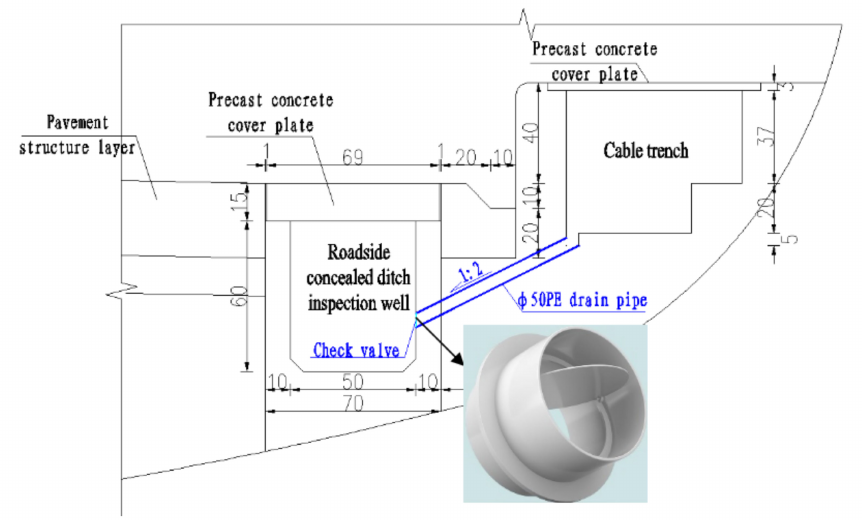
Figure 10. Design drawing of optimized cable trench (dimensions in the drawing are in